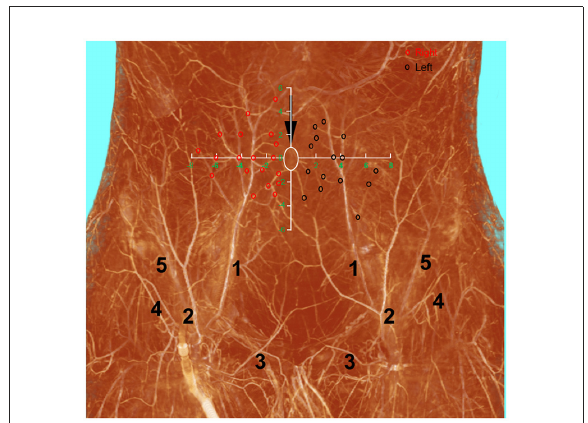
FIGURE1 A diagram describing the distribution of DIEP perforators drawed on the three-dimensional visualization of the abdominal wall of a male cadaver after angiographic injection. DIEP, deep inferior epigastric perforator; white ellipse, umbilicus, red and black circles–DIEP perforator locations; 1, deep inferior epigastric artery; 2, superficial inferior epigastric artery; 3, superficial external pudendal artery; 4, superficial iliac circumflex artery; 5, deep iliac circumflex